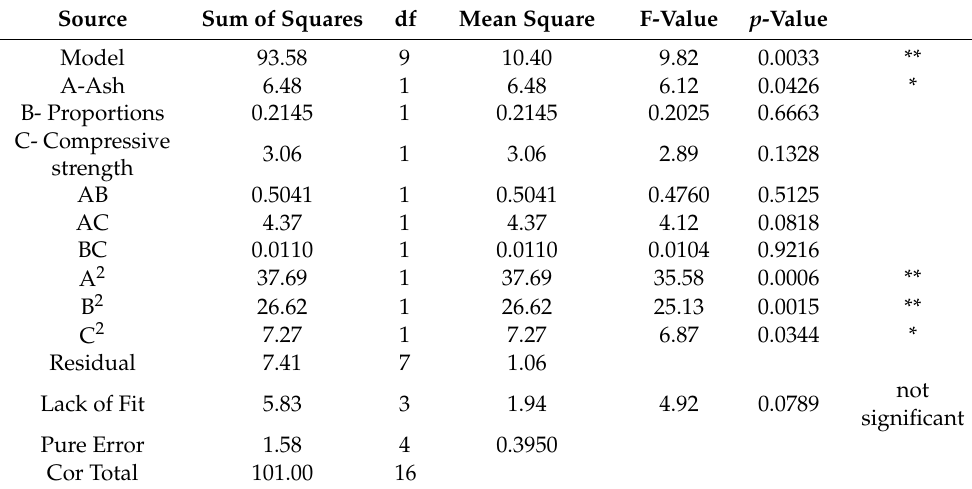
Table 5. Analysis of variance for the regression